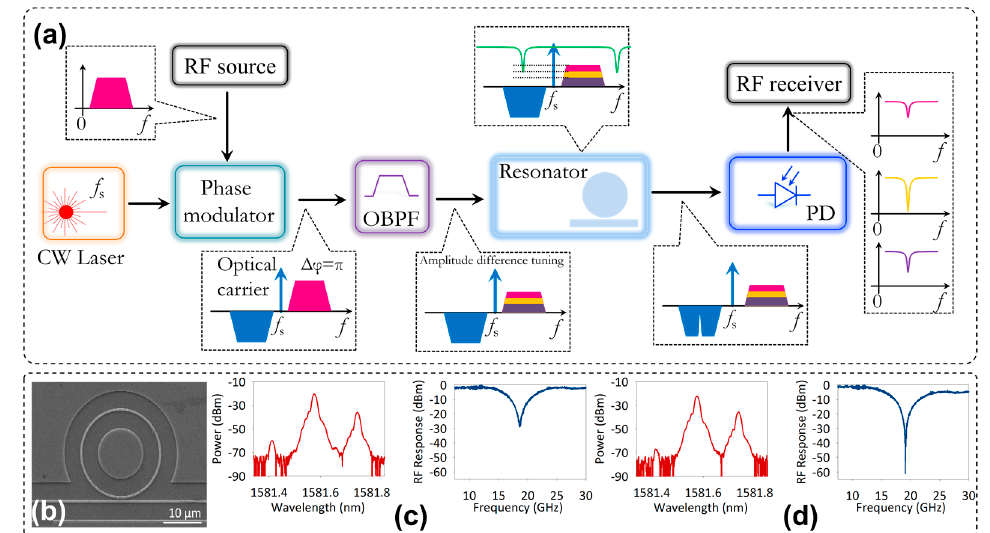
Figure 19. ( a ) Schematic illustration of the notch MPF with rejection ratio tunability proposed in [49], ( b ) SEM image of the silicon MRR, ( c , d ) Optical spectra after the tunable optical bandpass filter (OBPF) (dashed lines) and the corresponding MPF responses. Courtesy of and adapted from Jian Wang [49].